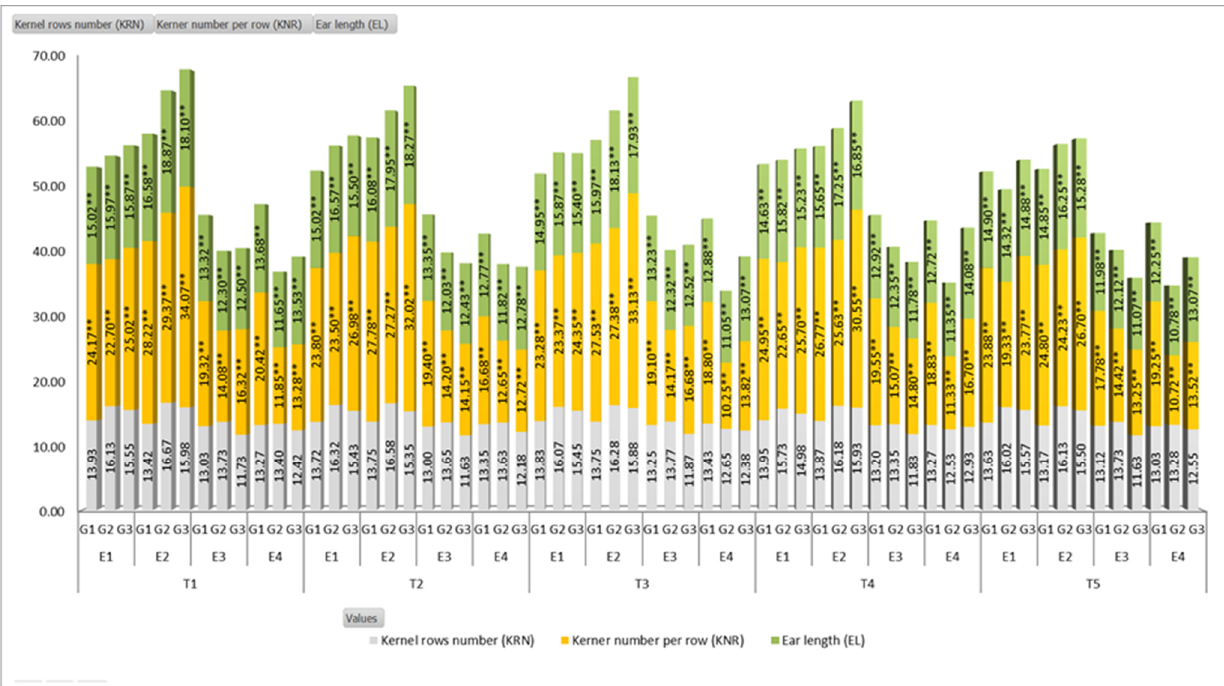
Figure 2. Effects of genotypes (G), Year–location interaction (E) and defoliation (T) on the kernel row number (KRN), number of kernels per row (KNR), the ear length and variability of means by the application of ANOVA. ** Significant at the 0.01 level; * significant at the 0.05 level, without asterisks—not significant.